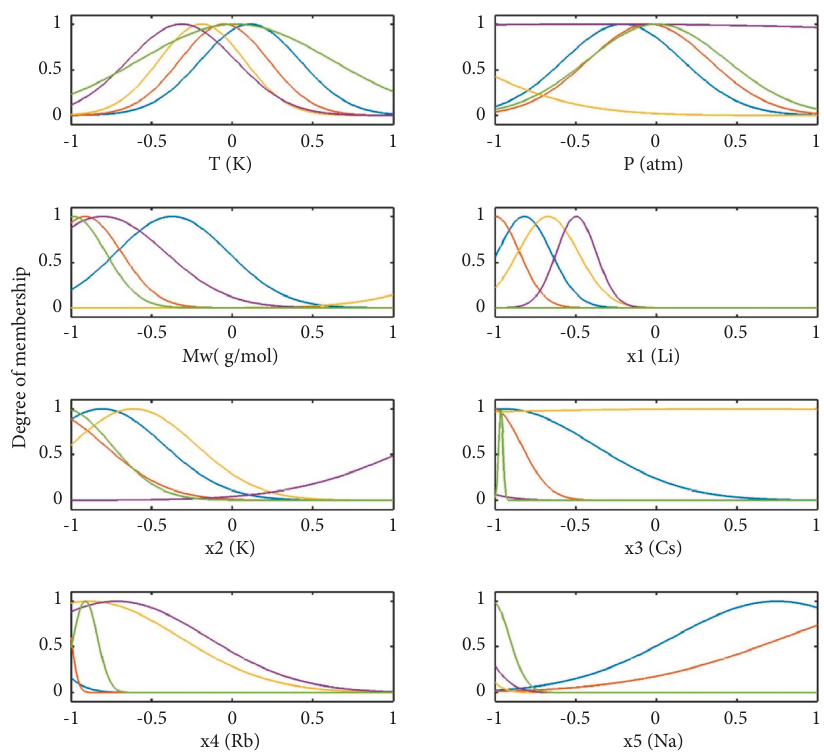
Figure 4: Trained membership function.